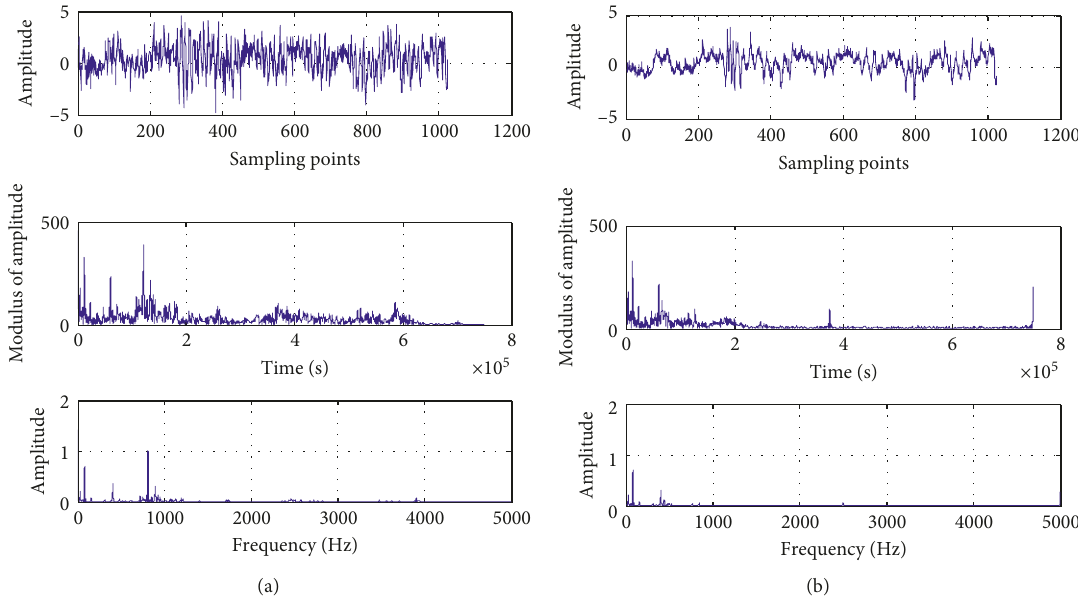
Figure 18: (a) Outer wear signal, outer wear Fourier transform, and power spectral density plot; (b) denoising signal, Fourier transform, and power spectral density plot after improving